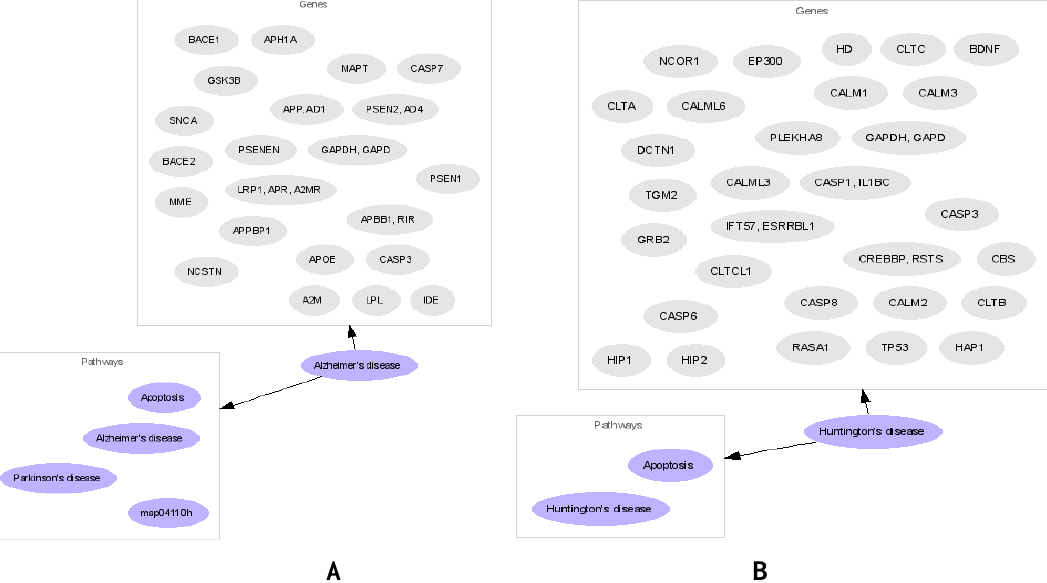
Figure 5: Alzheimer’s (A) and Huntington’s (B) disease and their relation to other genes and related pathways as shown in VINEdb